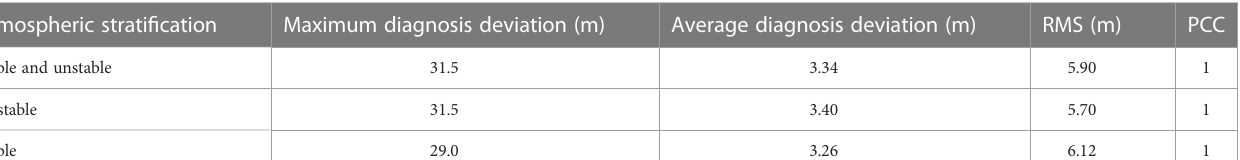
TABLE 4 Analysis of EDH diagnosis results.